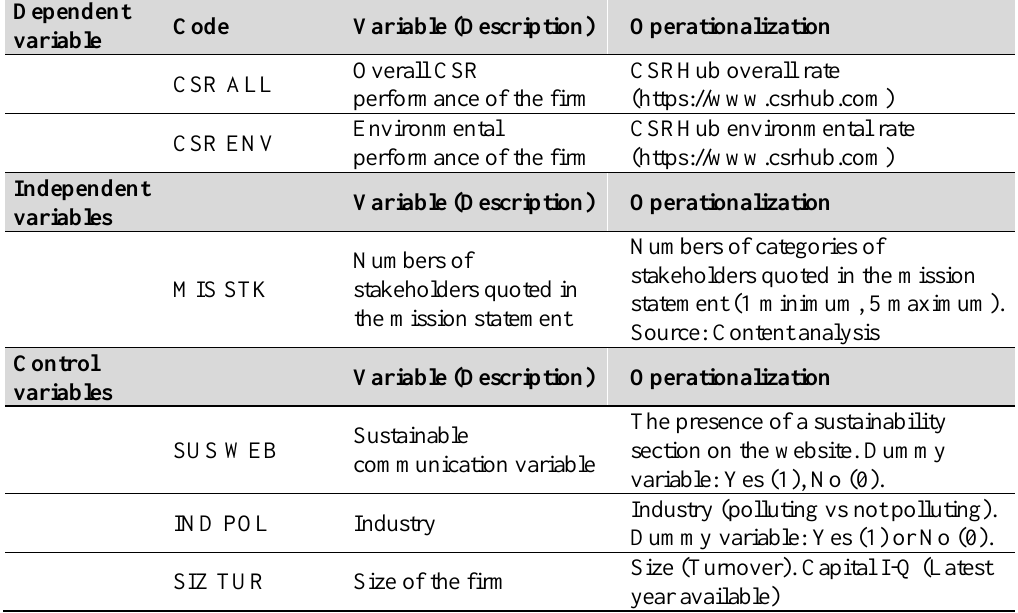
Table 1: Definition and Operationalization of Variables Dependent